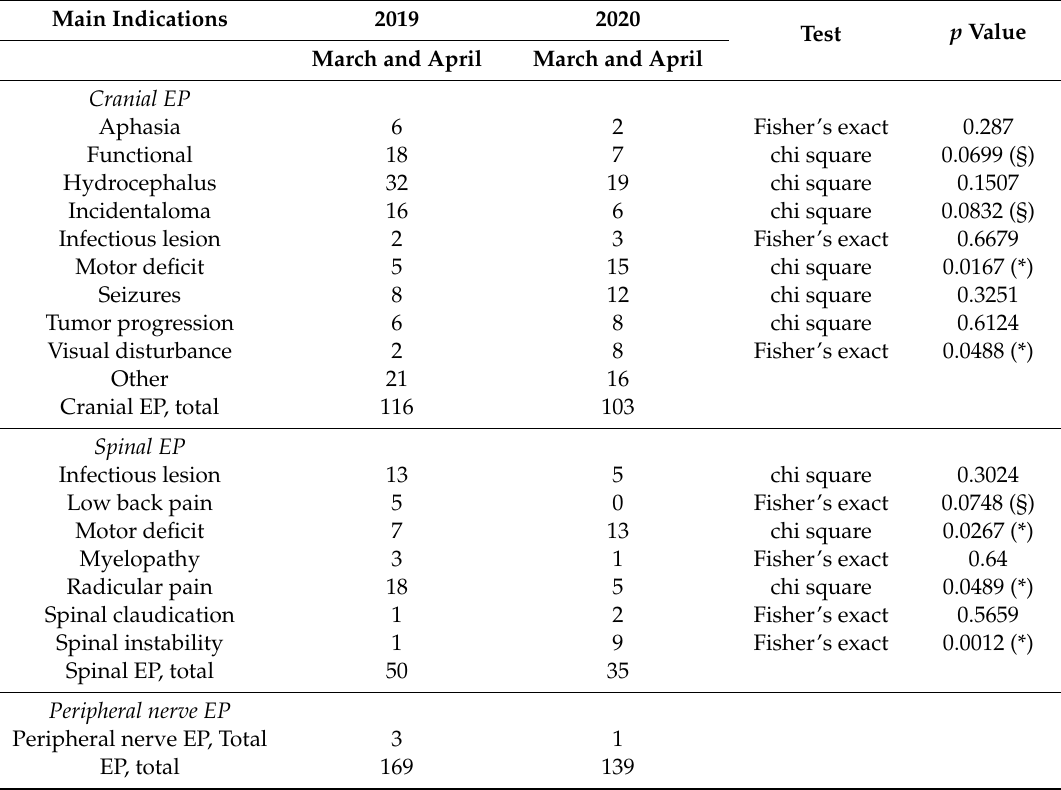
Table 2. Main indications for elective procedures at our department in March and April 2020 as compared to March and April 2019.